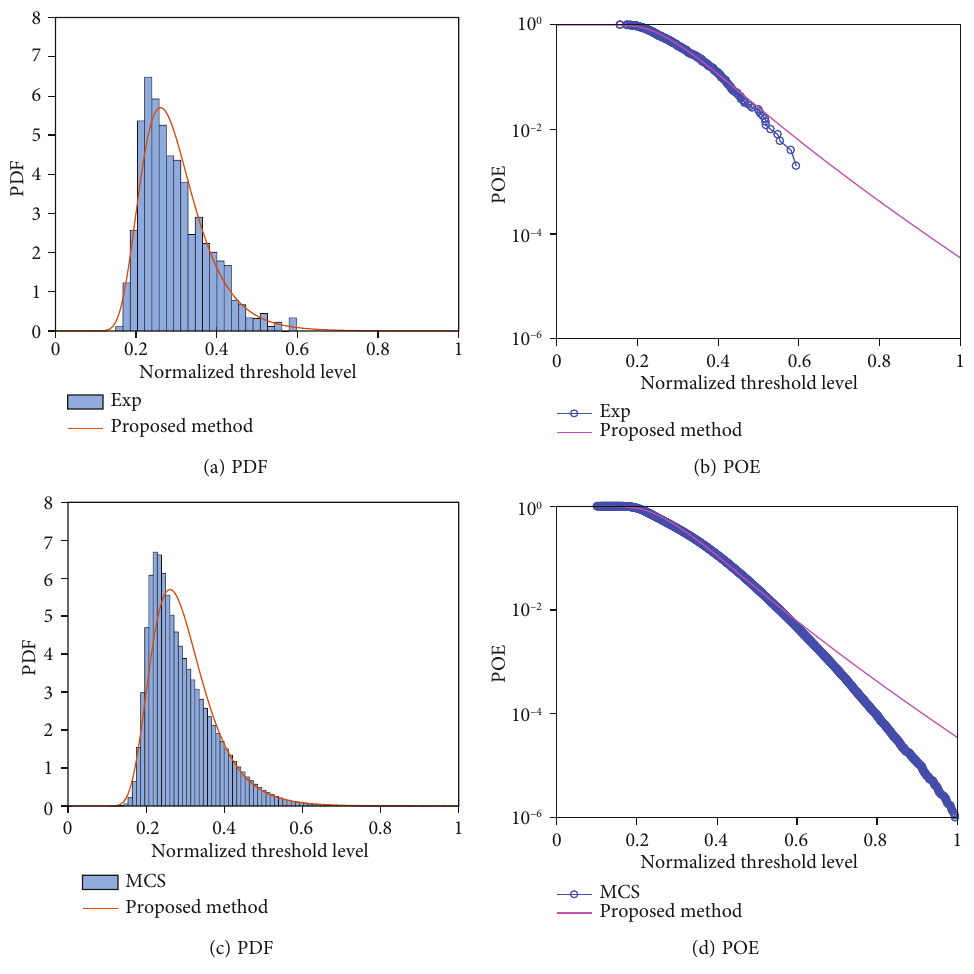
Figure 8: Comparison of histogram, PDF, and POE for the nonlinear structure. Table 7: The value of the objective function for the nonlinear